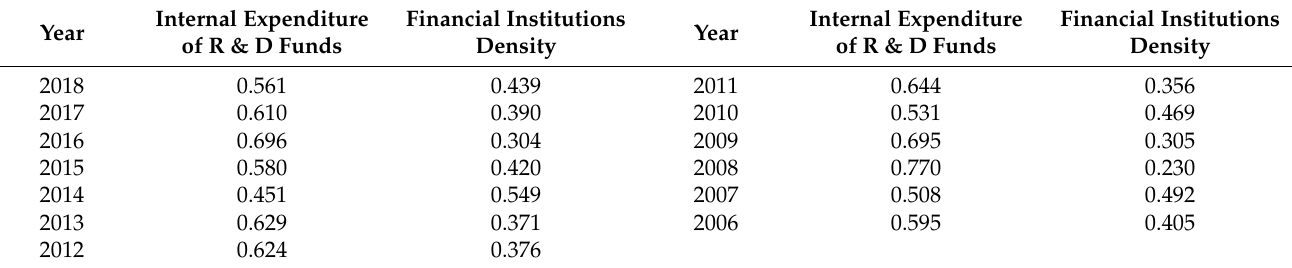
Table A2. Weight of material capital dimension.